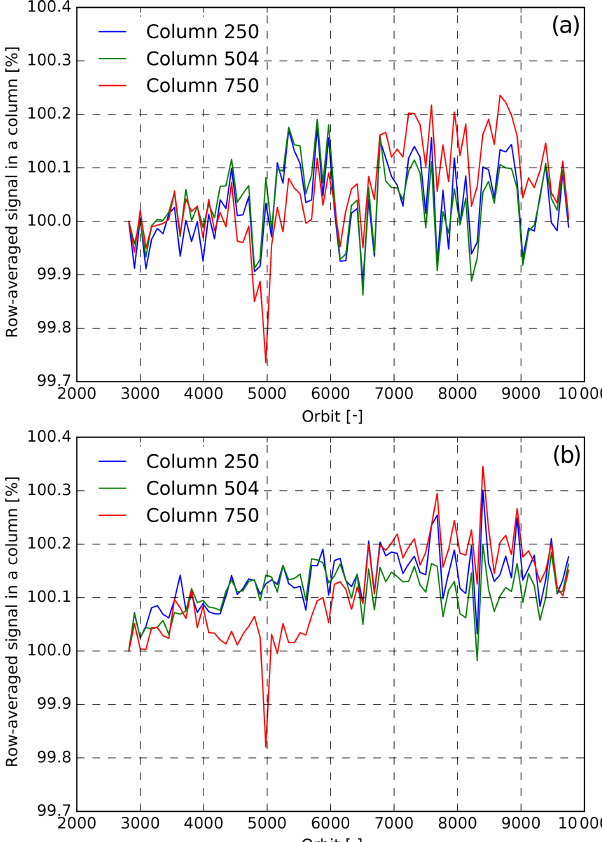
Figure 17. The residual temporal variation components R k of the ir- radiance measurements as modelled in Eq. (1) over time. The resid- uals have been computed independently for all spectrometers, and the similarity is not imposed by the model. (a) UV (blue) and SWIR (black) spectrometers. The magnitude is notably smaller than for the UVIS (green) and NIR (red) spectrometers in (b) .